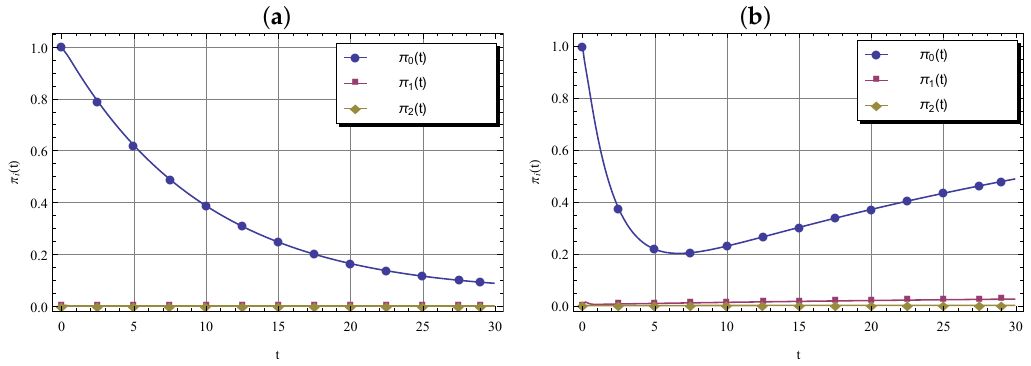
Figure 5. TDSSPs π i ( t ) , i = 0,1,2 for a = 10 ( a ) and for a = 2 ( b